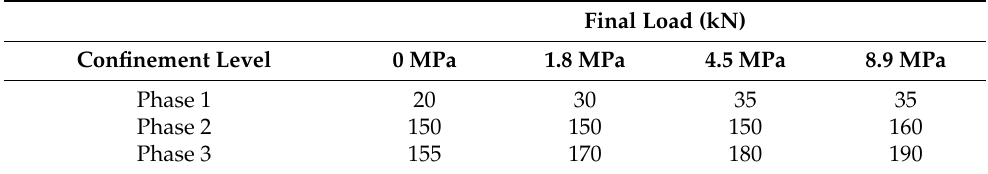
Table 3. Summary of Final Tensile Load in Each Phase.